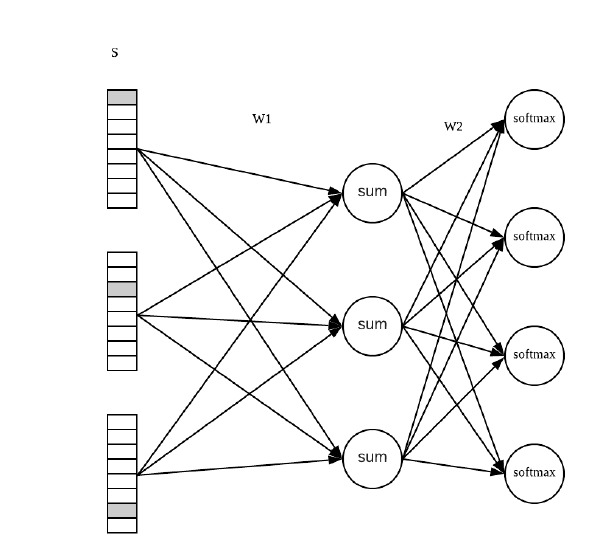
Figure 7. An example of embedding: Word2Vec, where the layer in the middle can be used as an embedding representation